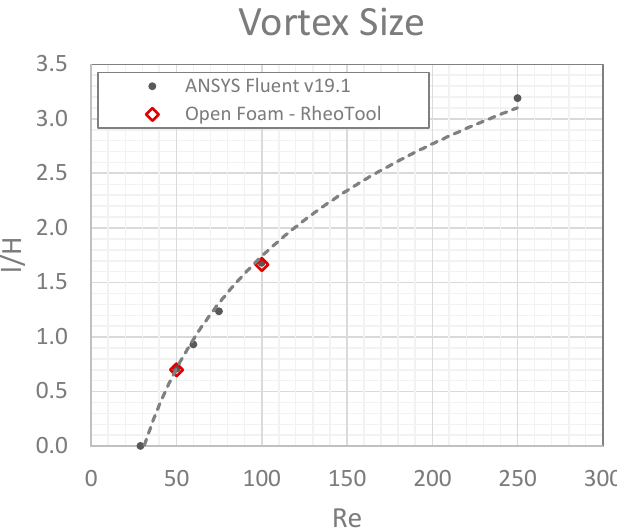
Figure 5. Non-dimensional inertial vortex length for Newtonian flow. The dashed line (logarithmic regression) is added to highlight the trend of the Newtonian vortex length solution.